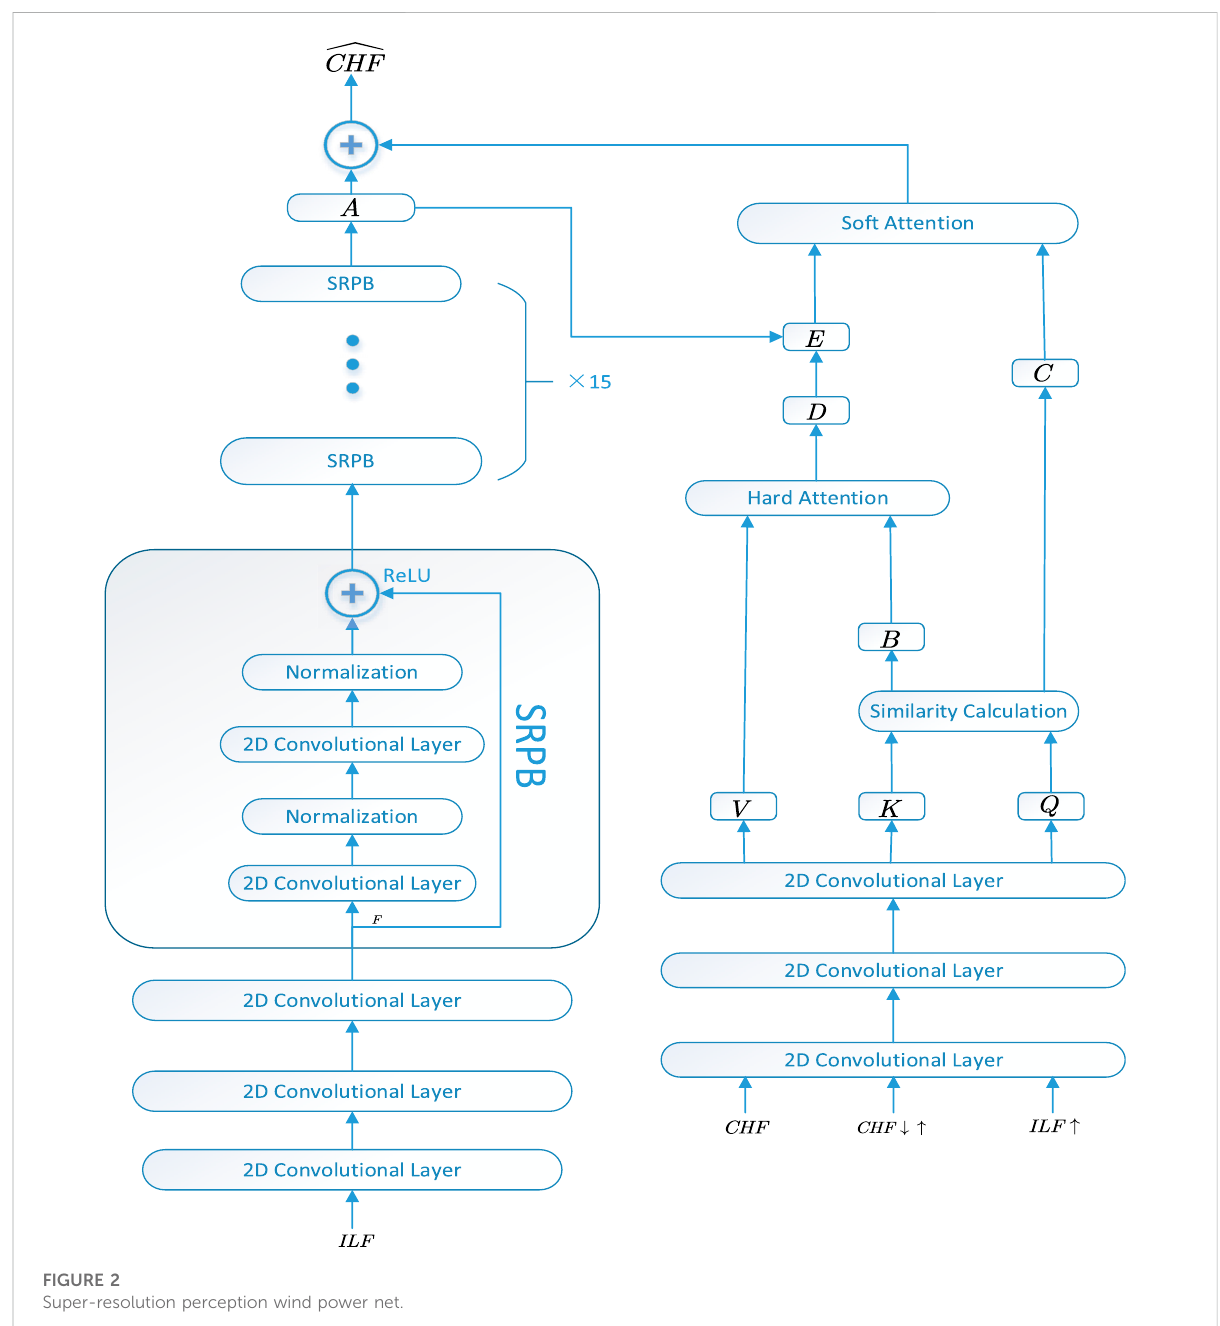
FIGURE 2 Super-resolution perception wind power